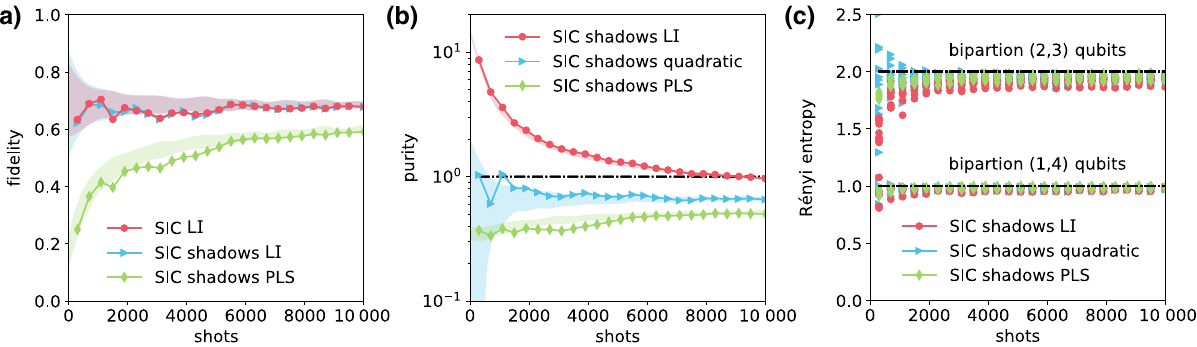
FIG. 4. SIC-based classical shadow tomography of a five-qubit absolutely maximally entangled (AME) state. We compare the convergence of LI [Eq. (2)] and classical shadow tomography using SIC measurements [Eqs. (4)–(6)]. We additionally use PLS following Refs. [27–29], explained in the text. (a) In terms of convergence, we find both SIC LI from Eq. (2) and SIC shadows LI from Eq. (4) to overlap, which is expected due to their similarity. We remark that in terms of reconstruction SIC shadows LI is computationally more efficient; see Fig. 3. PLS incorporates physical constraints [tr (ρ) = 1 and ρ > 0], but underestimates the fidelity for a small number of shots and converges very slowly, requiring at least an order of magnitude more shots (indeed slower than MLE, additionally confirmed by experiments in Appendix A 2 and numerical simulations in Appendix A 6). Here, connected data points represent an individual experimental run, while shaded regions represent 1 standard deviation around the mean value of multiple batches of experimental data at identical shot numbers. (b) When estimating purity, LI shows highly unphysical behavior under insufficient statistics and does not converge in the plot. Physical constraints can be corrected by PLS, although at the cost of much slower convergence. On the other hand, classical shadow purity estimators [Eq. (6)] display very quick convergence. The dash-dot line indicates the ideal value. (c) Estimated Rényi entropies [Eq. (9)] from subset purities across all bipartitions converge very quickly for all methods. The lack of difference between the methods is likely due to the small system sizes, and for increasing bipartition sizes, we expect similar behavior as in (b). Note that bipartitions are denoted by tuples ( 2, 3 ) qubits and ( 1, 4 ) qubits, referring to the number of qubits in each